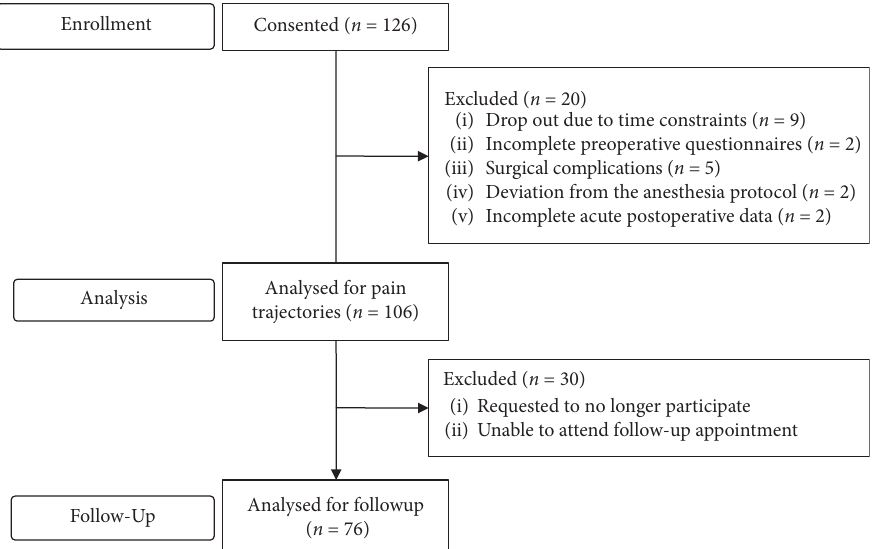
Figure 1: Study flowchart of cohort for the